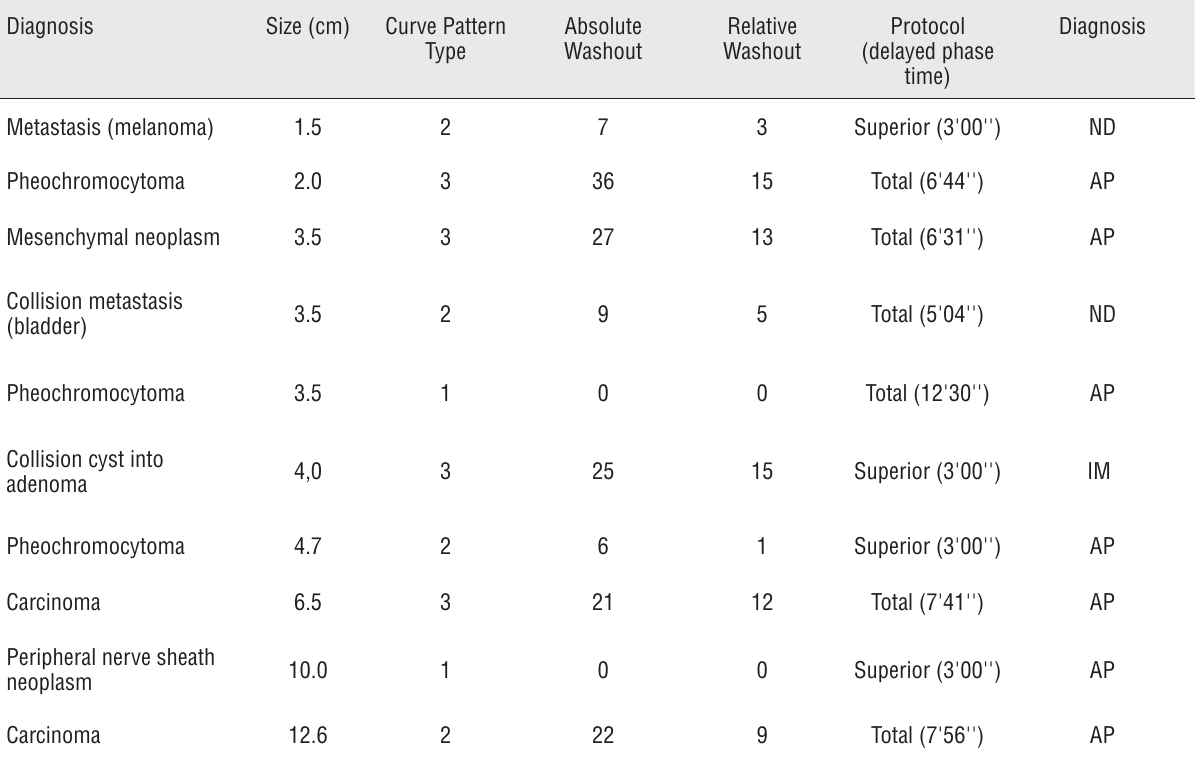
Table 2 - Final diagnosis, size, enhancement pattern and protocol performed on magnetic resonance imaging of the evaluated lipid poor adrenal adenomas (N=